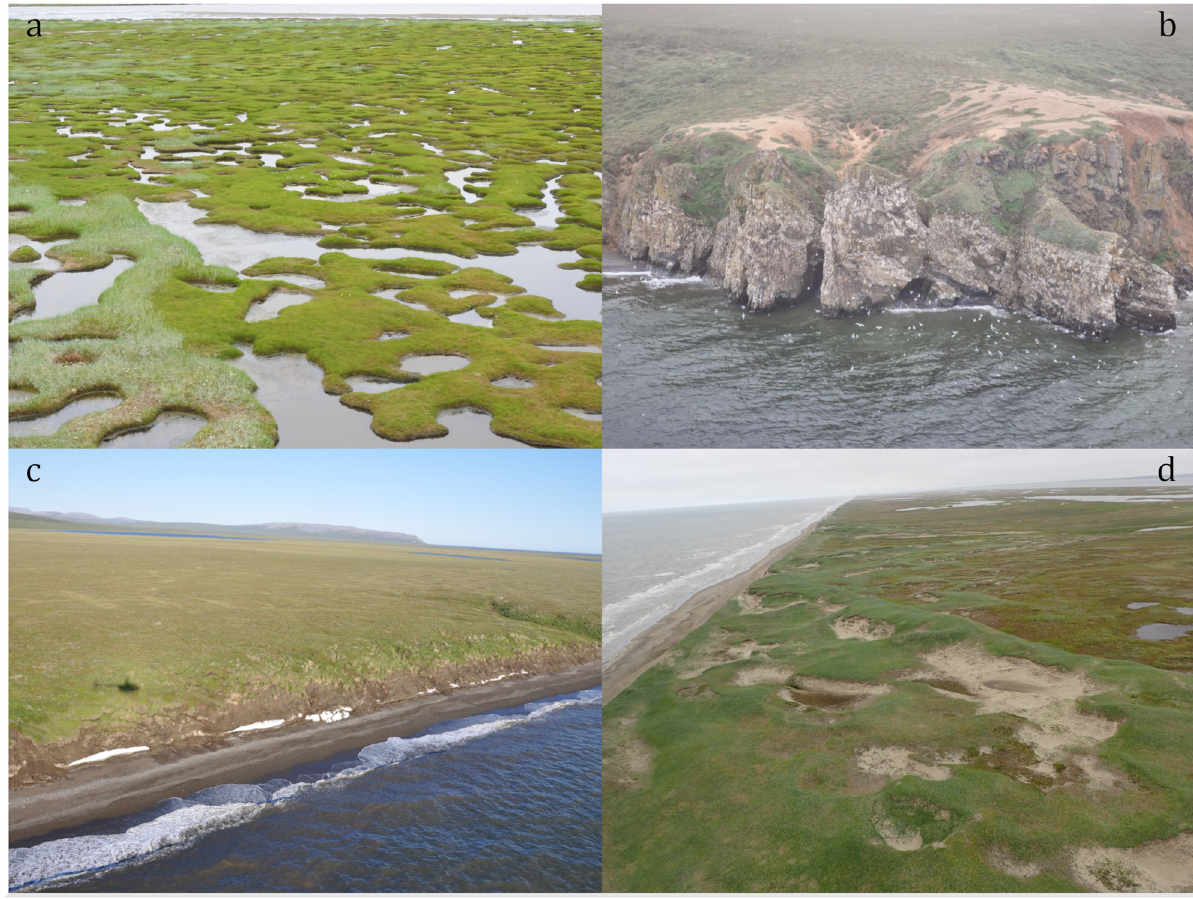
Fig 2. Examples of coastal geomorphology features. A. Patterned salt marsh at the mouth of the Nugnugaluktuk Estuary, eastern BELA. B. Bedrock outcrop on the coast of Goodhope Bay, eastern BELA. C. Ice-wedge polygon tundra bluff along the beach north of Cape Krusenstern Lagoon, CAKR. D. Active and stabilized sand dunes on the barrier island of Cowpack Lagoon, northern BELA. Photo A NPS, public domain, B, C & D photos from ShoreZone [33], licensed CC By